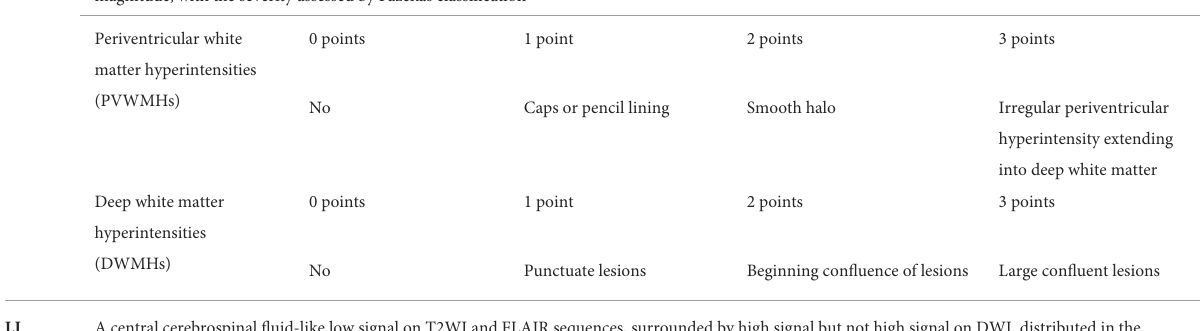
TABLE 1 WMH, LI, CMBs, and ePVS scoring criteria for imaging examinations. WMH High signal in the lateral paraventricular or deep brain white matter on T2WI or FLAIR sequences and iso/low signal on T1WI, which may vary in magnitude, with the severity assessed by Fazekas